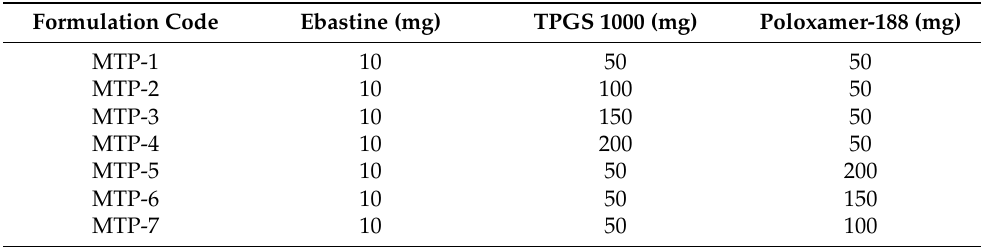
Table 1. Composition of micelles formulations. Formulation